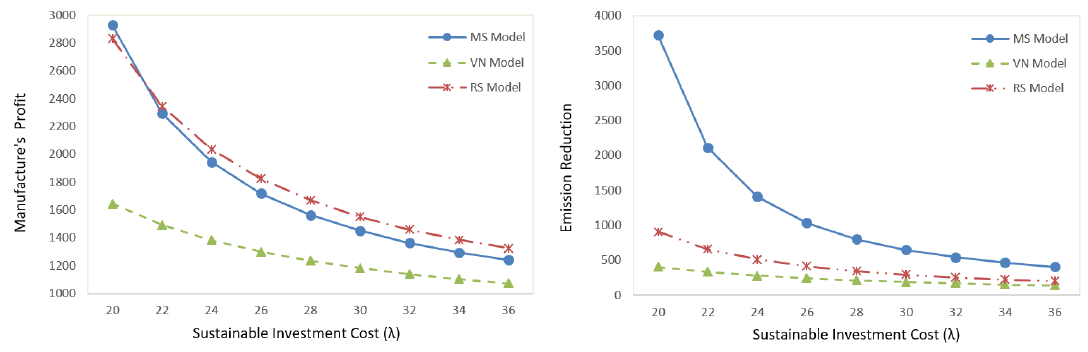
Figure 4. Impact of the sustainable investment cost on the ( left ) manufacturer’s profits and ( right ) emission reduction in different power